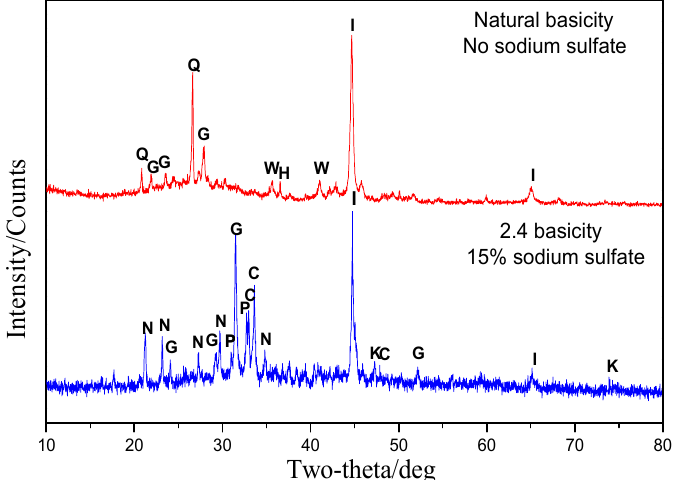
Figure 11. X ‐ ray diffraction pattern of the reduced briquettes. Q ‐ SiO 2 ; G ‐ CaAl 2 Si 2 O 8 ; W ‐ FeO; H ‐ Figure 11. X-ray diffraction pattern of the reduced briquettes. Q-SiO 2 ; G-CaAl 2 Si 2 O 8 ; W-FeO; FeO ∙ Al 2 O 3 ; I ‐ Fe; P ‐ Ca 3 (PO 4 ) 2 ; N ‐ NaAlSiO 4 ; C ‐ Ca 2 SiO 4 ; K ‐ CaAl 2 O 4 . Reducing at 1350 °C for 10 min with H-FeO ¨ Al 2 O 3 ; I-Fe; P-Ca 3 (PO 4 ) 2 ; N-NaAlSiO 4 ; C-Ca 2 SiO 4 ; K-CaAl 2 O 4 . Reducing at 1350 ˝ C for C/Fe mass ratio of 0.48. 10 min with C/Fe mass ratio of